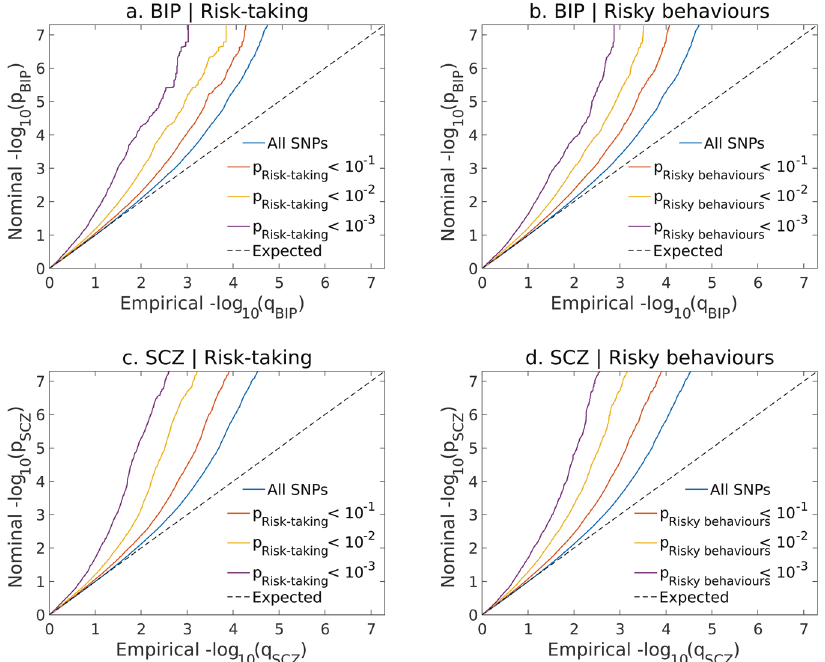
Fig. 2 Polygenic enrichment of SNPs associated with bipolar disorder (BIP) and schizophrenia (SCZ) dependent on their association with risk taking and risky behaviours. Visualising cross-trait enrichment between risk phenotypes, bipolar disorder and schizophrenia. Conditional Q – Q plots of nominal versus empirical − log10 p values in BIP ( a , b ) and SCZ ( c , d ) above the threshold of p < 5 × 10 − 8 as a function of the signi fi cance of their association with risk-taking (a./c.) and risky behaviours (RiskyBehav) (b./d.) at the level of p < 0.1, p < 0.01 and p < 0.001,